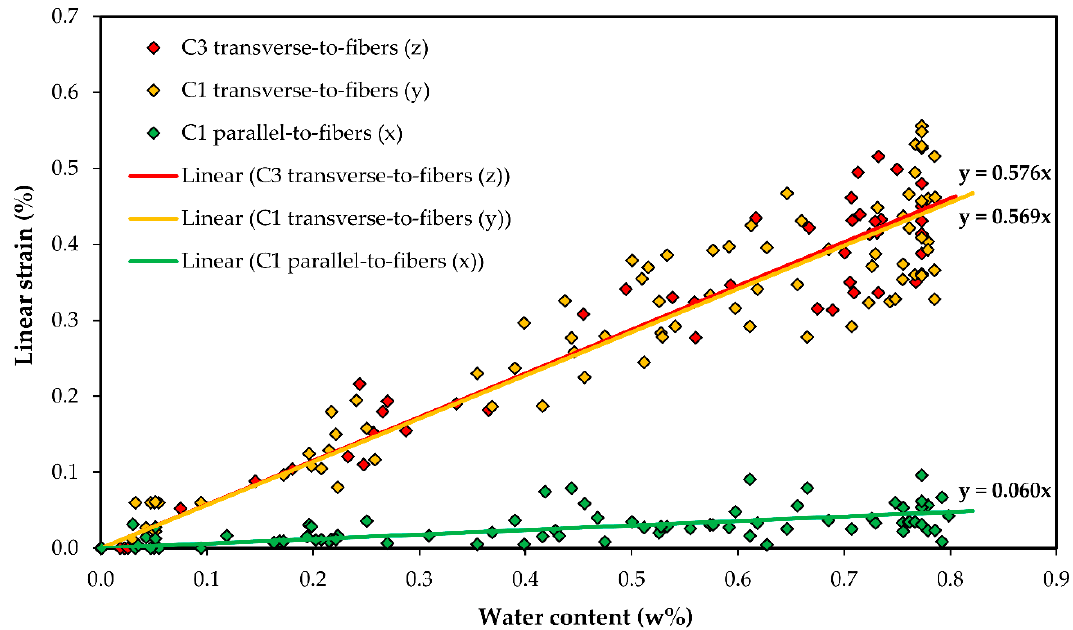
Figure 5. Experimental data and linear regression of hygroscopic swelling of epoxy polymer.